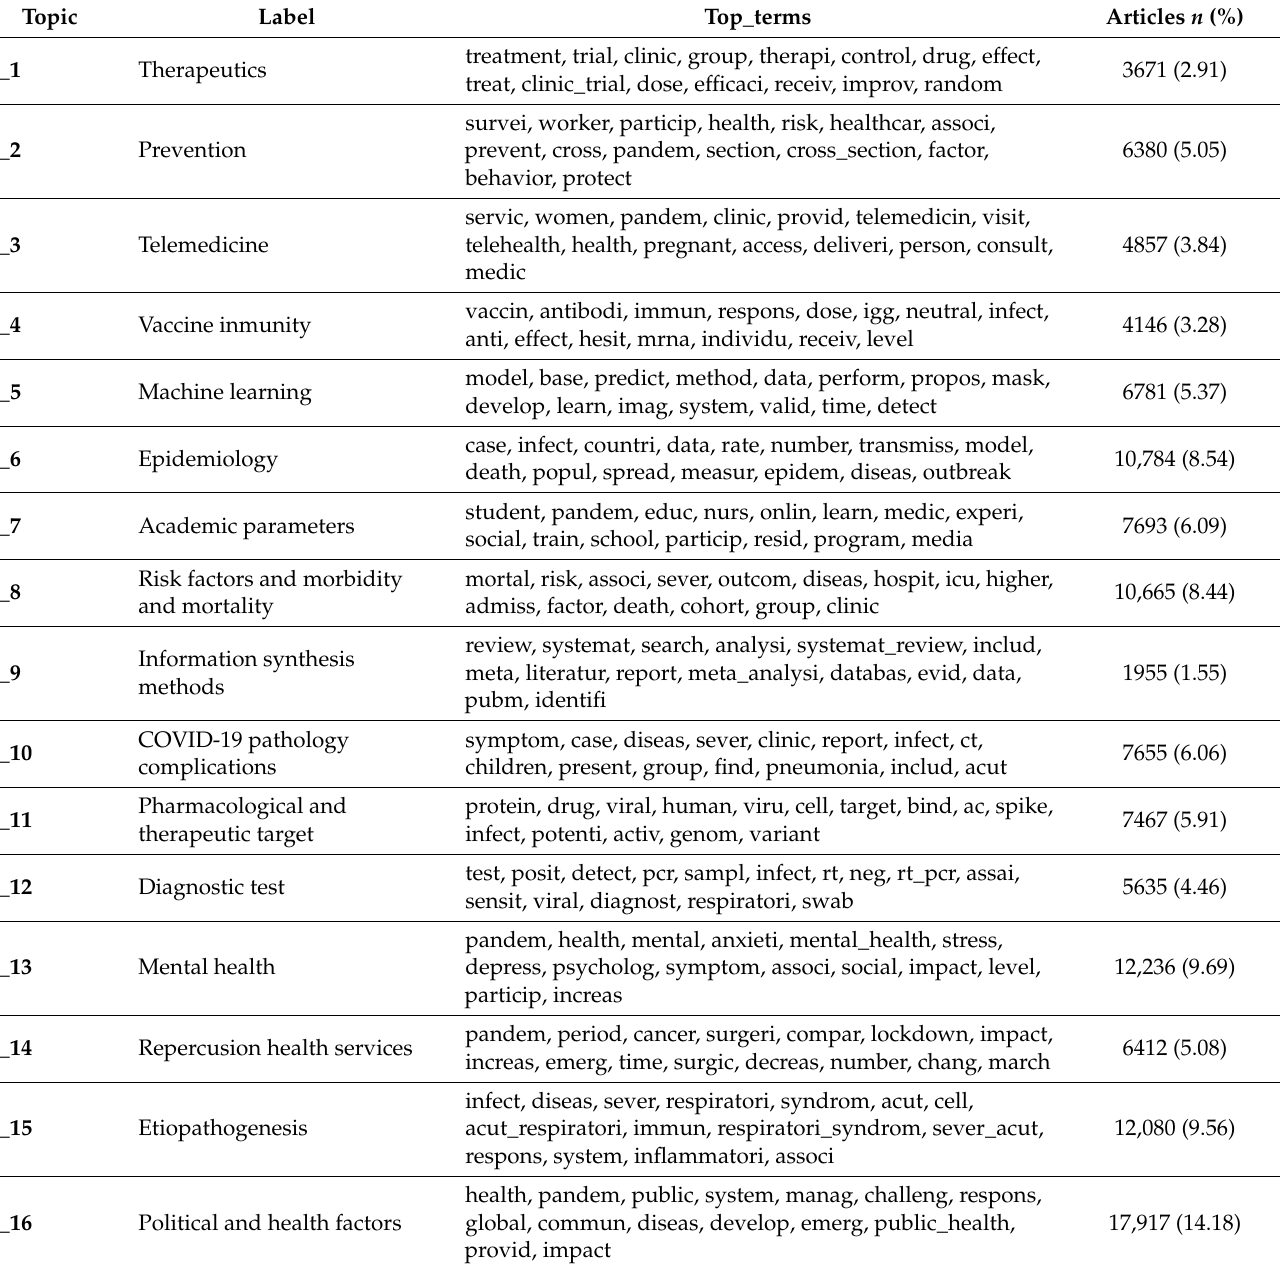
Table 4. 16 topics discovered from 126,334 articles published on COVID-19 in the period February 2020–January 2022. Each topic shows the 15 most likely terms (that is, the words with the highest probability), the label, and the number of published articles belonging to each